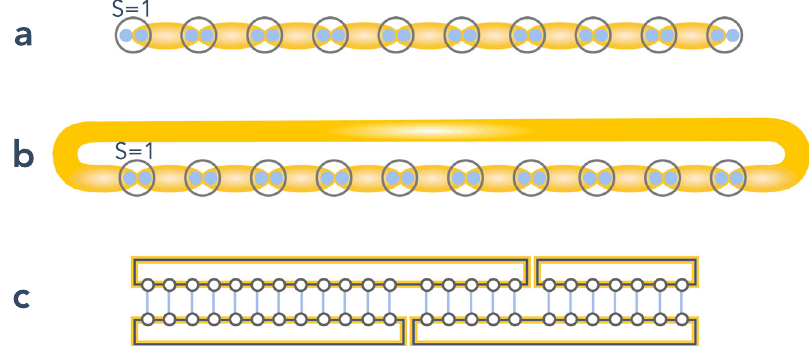
Fig. 7 Pictorial representation of the AKLT chains and overlaps. a Open and b closed (periodic) AKLT chains, and c MPS representation of the transfer matrices for the overlap between different AKLT chains diagram Fig. 4 in the small J / υ limit within the pure loop model